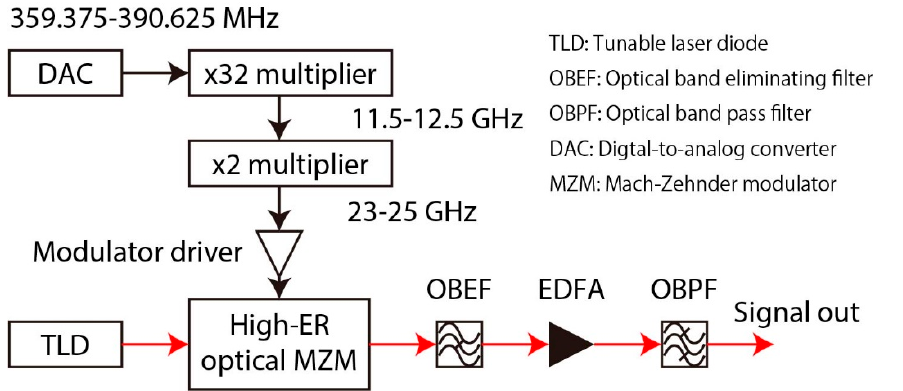
Figure 5. Setup for W-band frequency-modulated continuous-wave (FM-CW) signal generation [12].